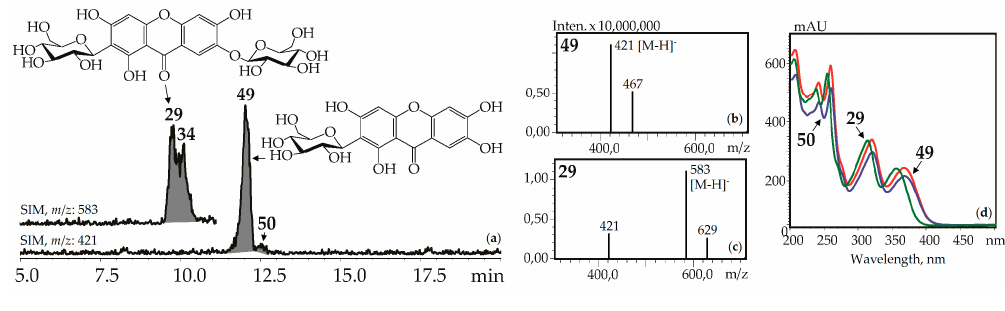
Figure 5. ( a ) HPLC-ESI-MS chromatogram of G. asclepiadea herb extract in SIM-mode ( m / z 421, 583). ( b , c ) Mass spectra (negative ionization) of compounds 49 (mangiferin) and 29 (mangiferin-7- O -glucoside), respectively. ( d ) UV spectra of compounds 29, 49, and 50 .